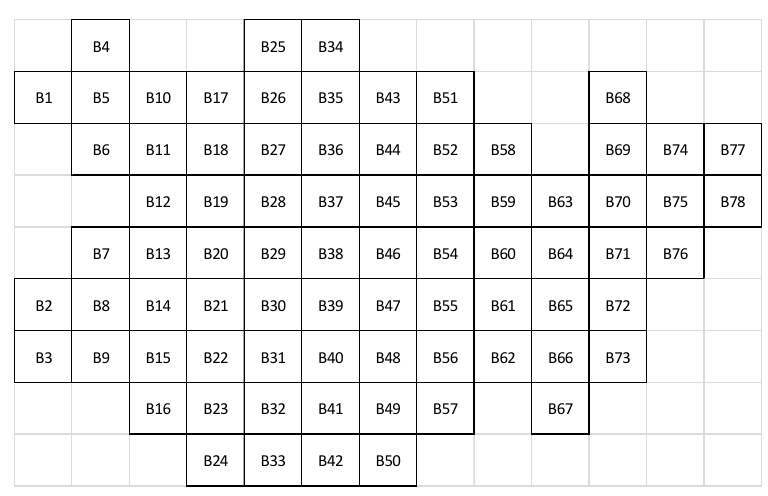
Figure 3. Model of the technological coal deposit.